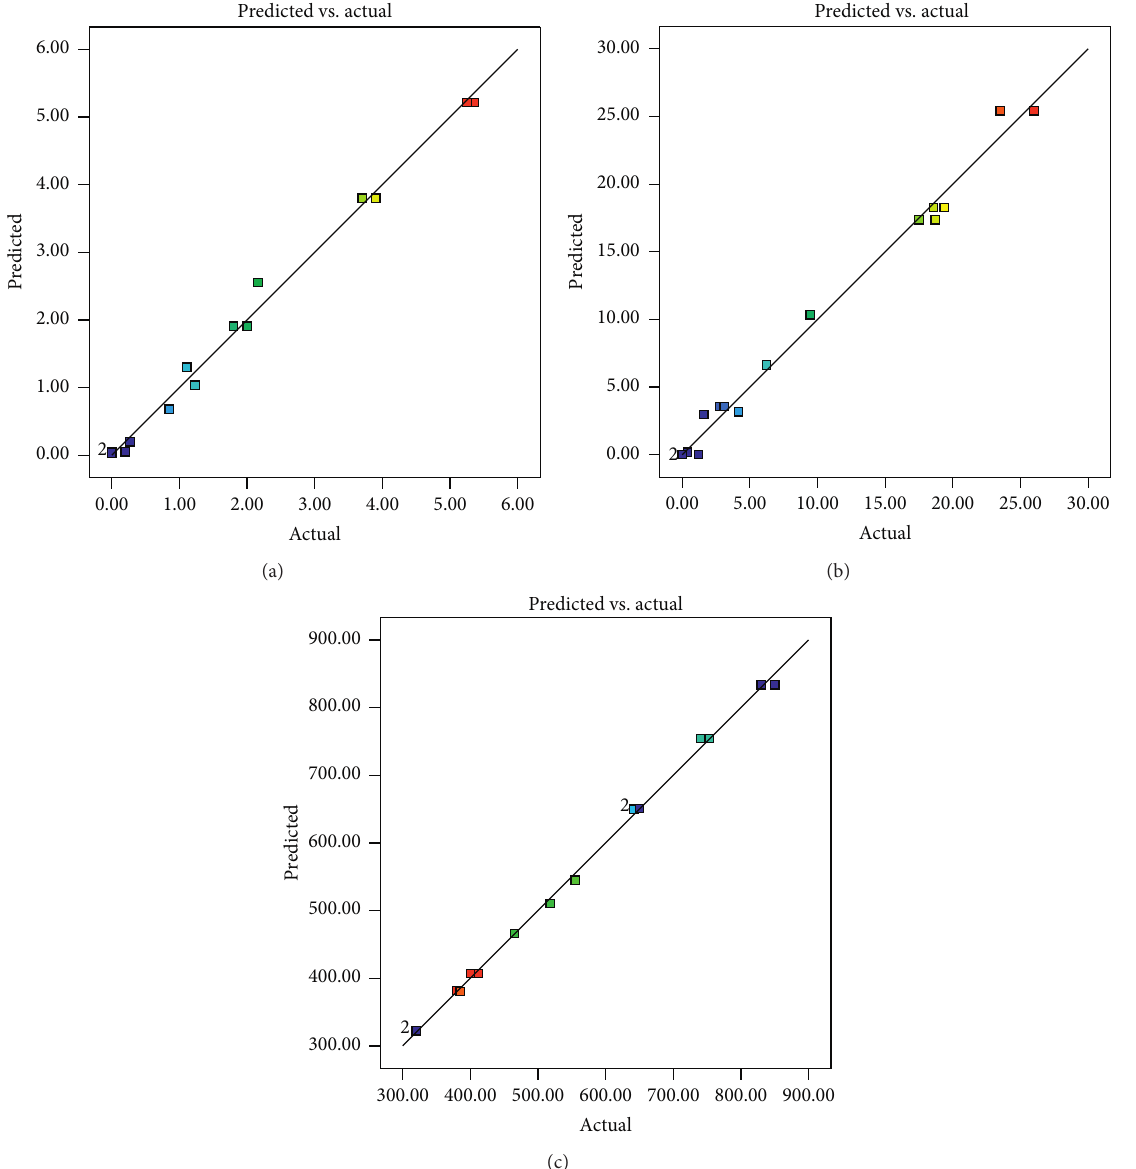
Figure 5: The corresponding relationship between predicted value and actual value. (a) Bleeding rate. (b) Segregation rate. (c) Slump